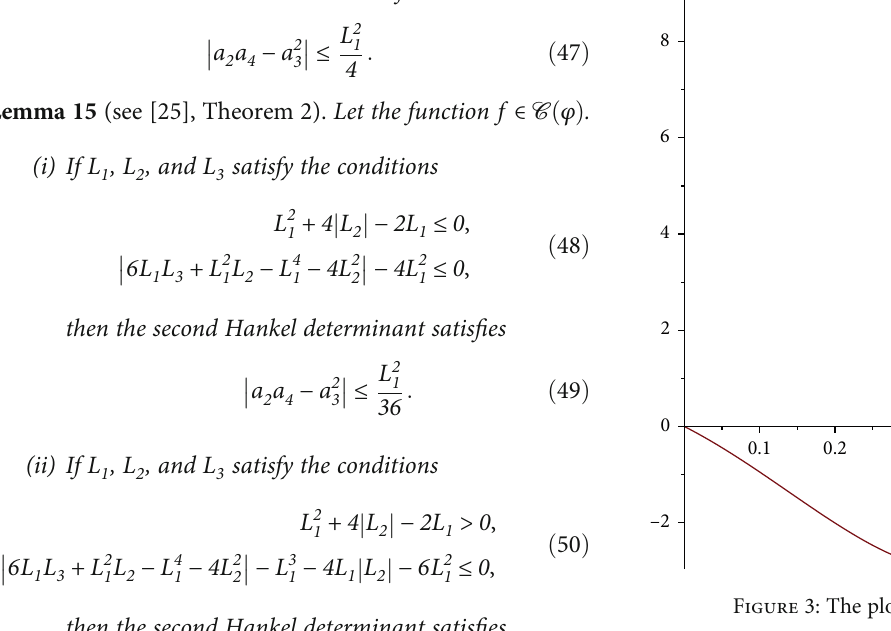
( s ) for s ∈ ð 0, 1/ 2